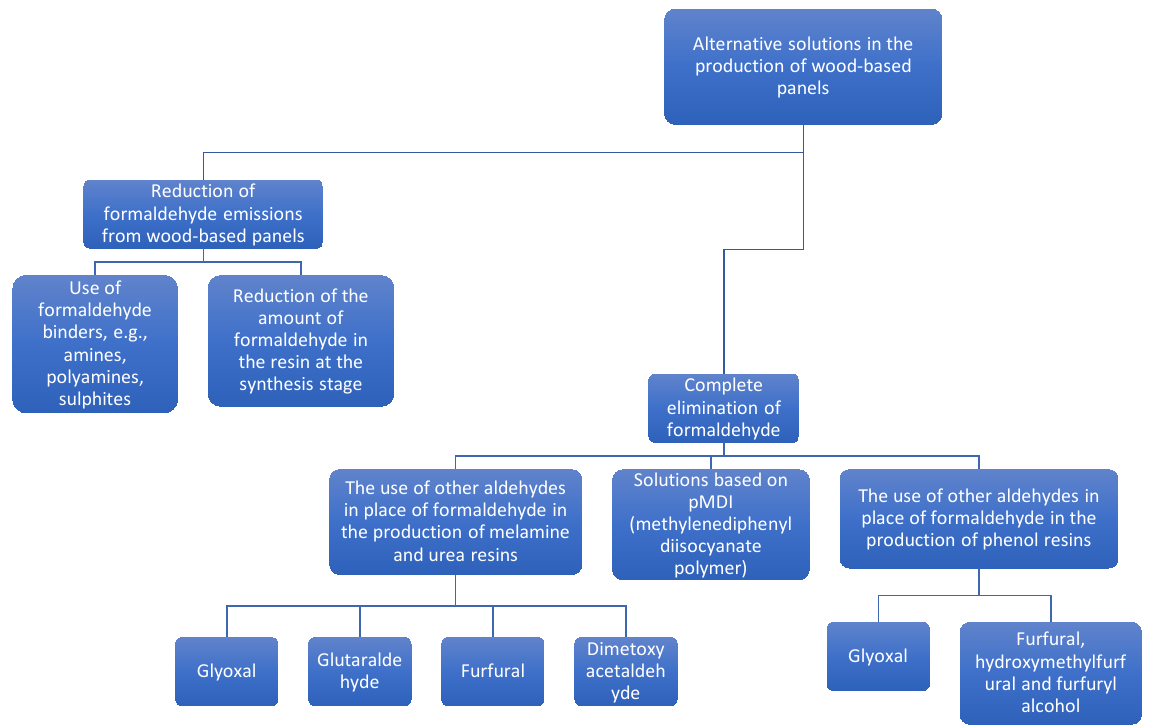
Figure 7. Summary of alternative solutions in the wood-based panel industry.